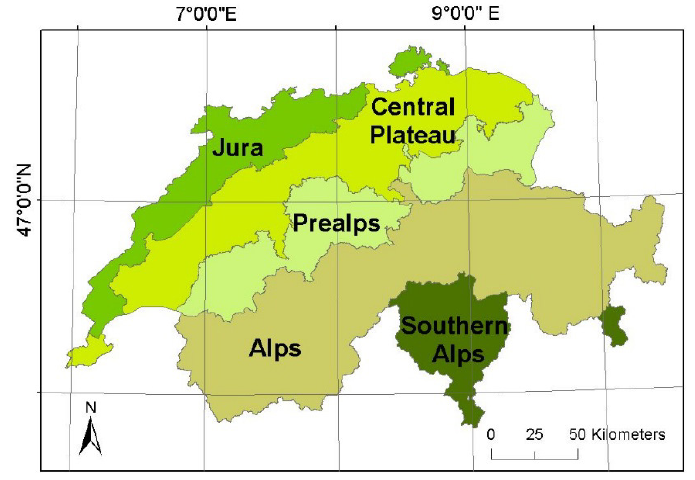
Figure 1. Swiss National Forest Inventory (NFI) forest production regions.